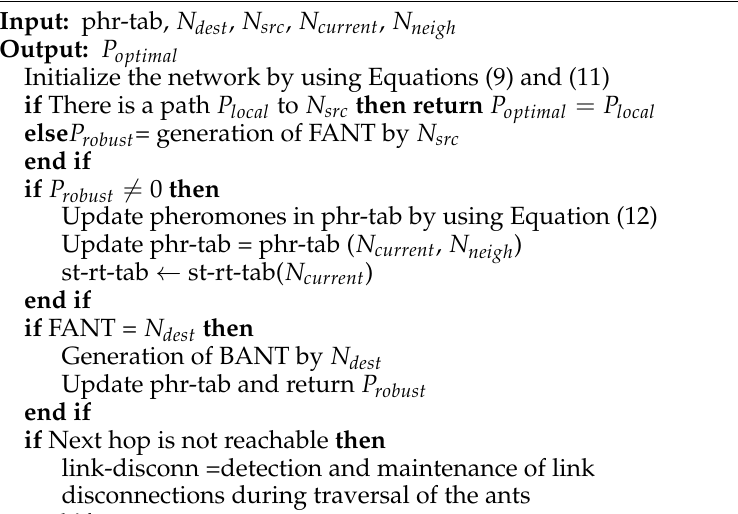
Algorithm 1 IEMACO protocol